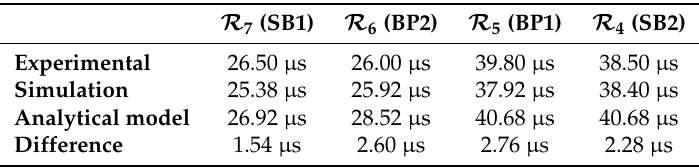
Table 9. Maximum end-to-end delay from three evaluation